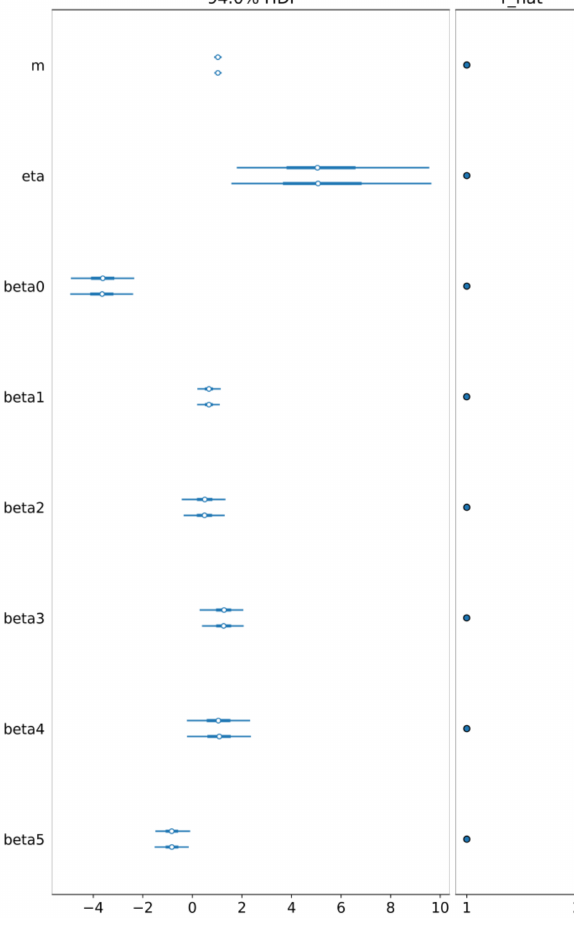
Figure 5. Gelman-Rubin convergence monitoring